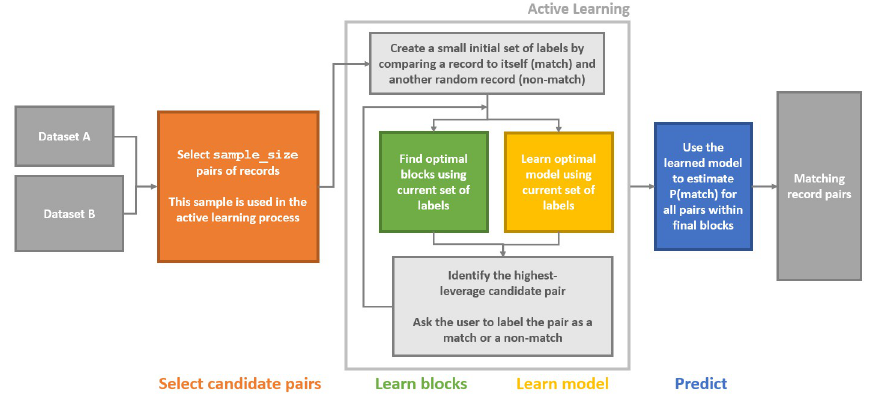
Fig 1. Dedupe’s active learning